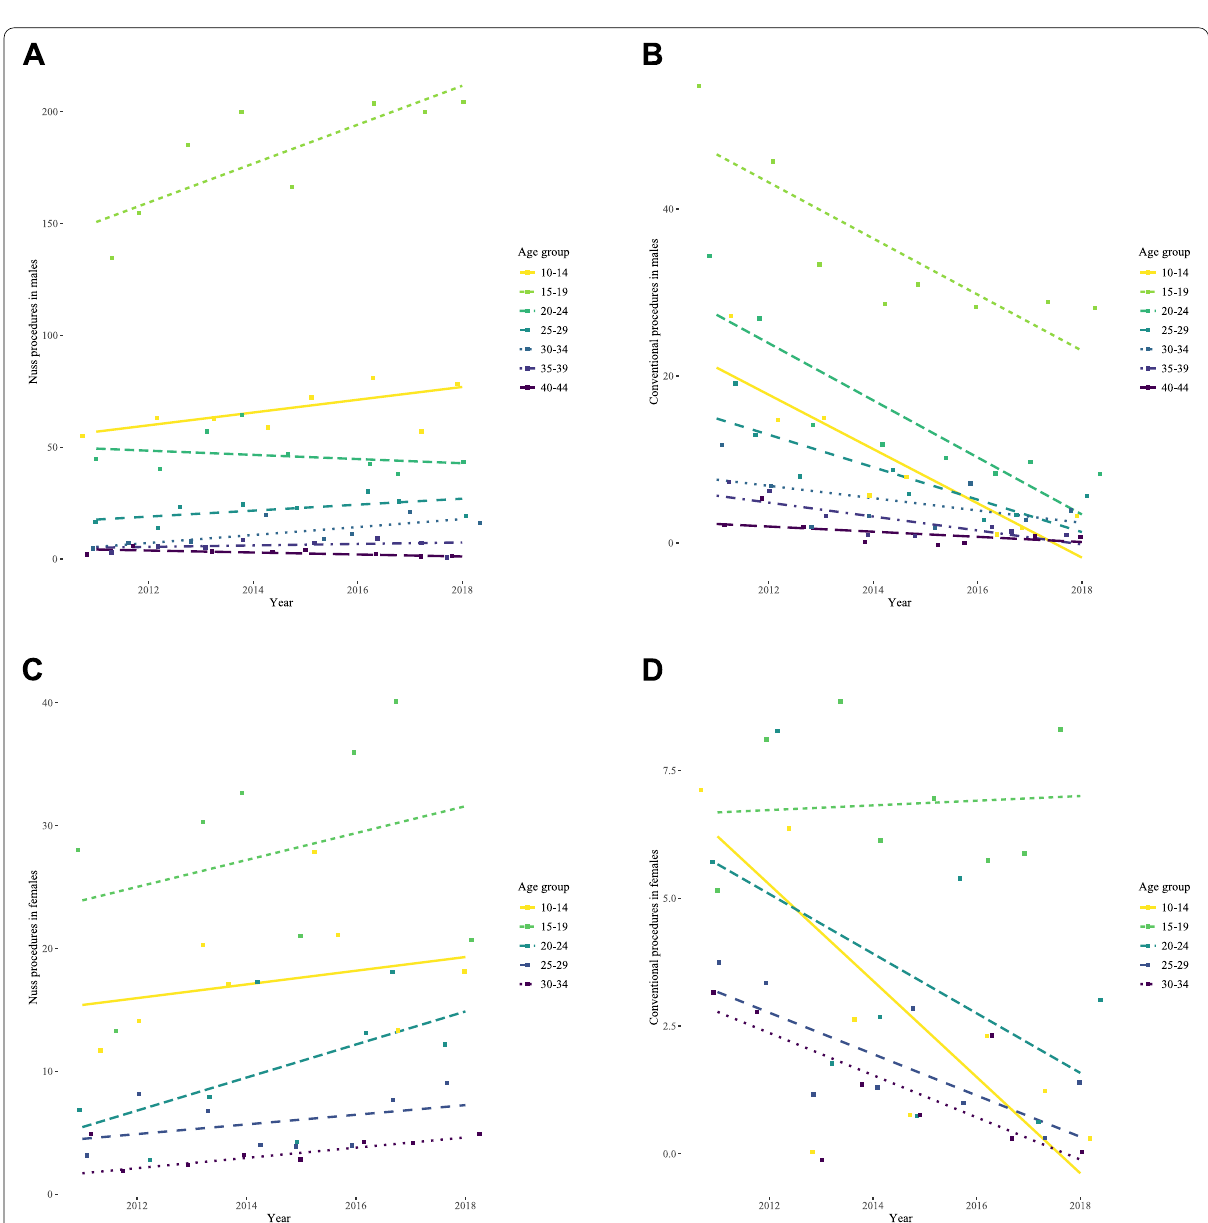
Fig. 2 Rates of funnel chest repairs per 100,000 persons. A Rate of minimally invasive and conventional funnel chest repairs per year in males. B Rate of minimally invasive and conventional funnel chest repairs per year in females. Only age groups with more than 0.5 procedures per 100,000 persons per year were